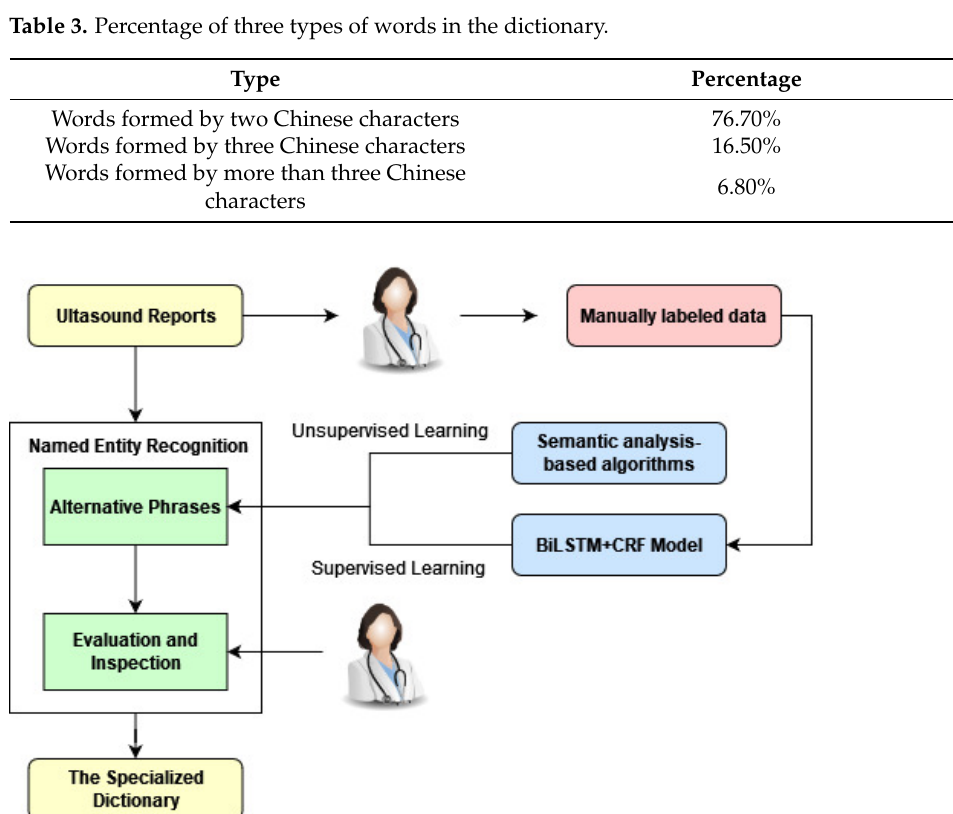
Figure 1. The process of building a